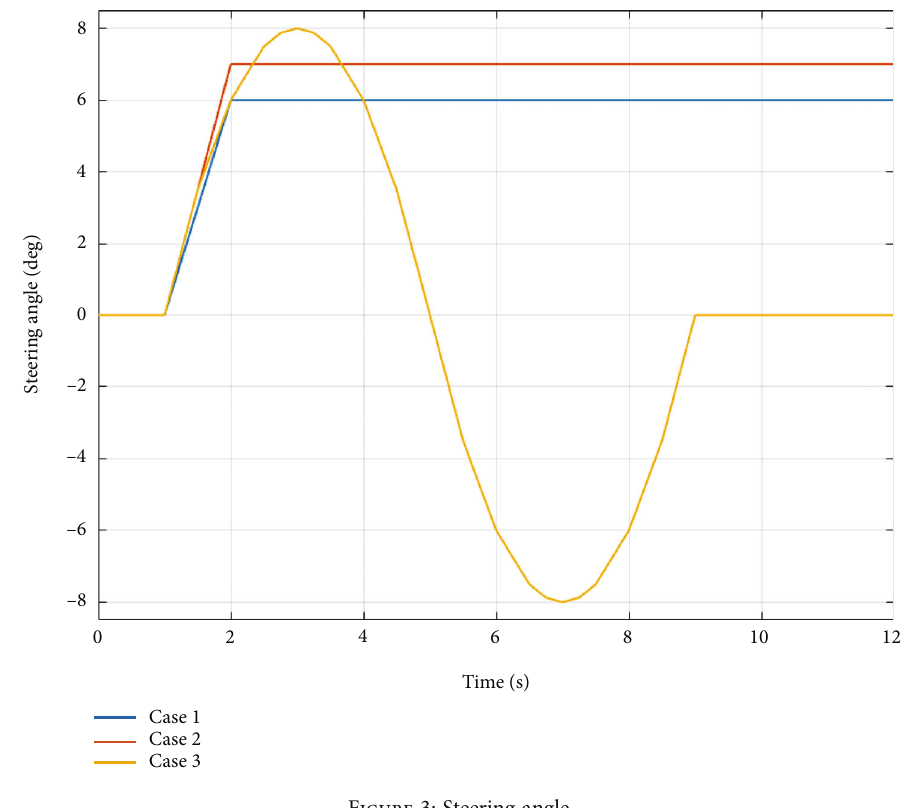
Figure 3: Steering